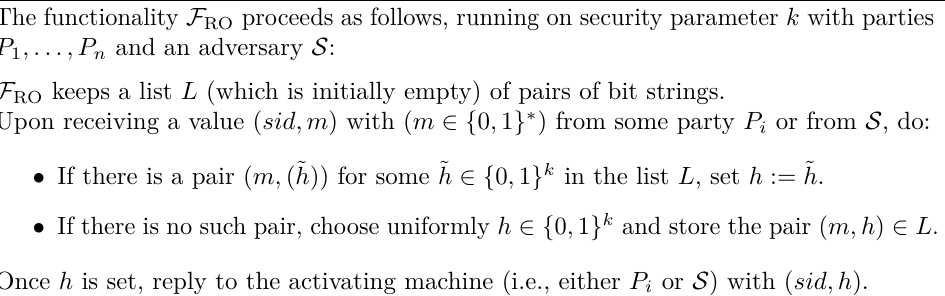
Figure 7: Ideal functionality F RO